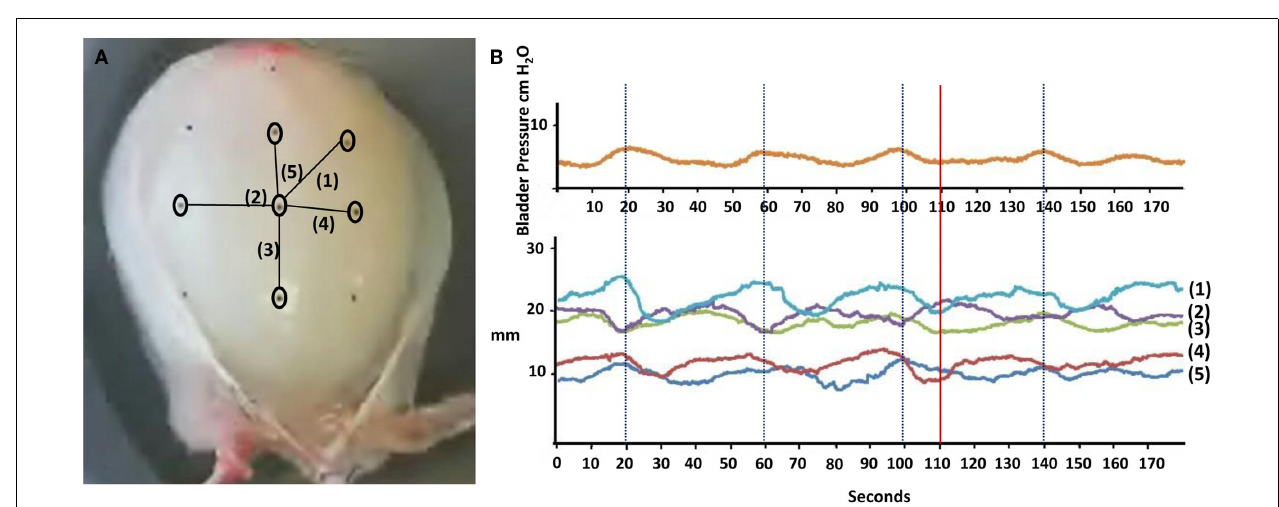
to (B) intravesical pressure fluctuations at 150ml. The graph shows changes in distance between pairs of carbon particles over a 3-min period for the five axes.The downward deflections represent shortening/contraction along the axis whilst the upward deflections represent